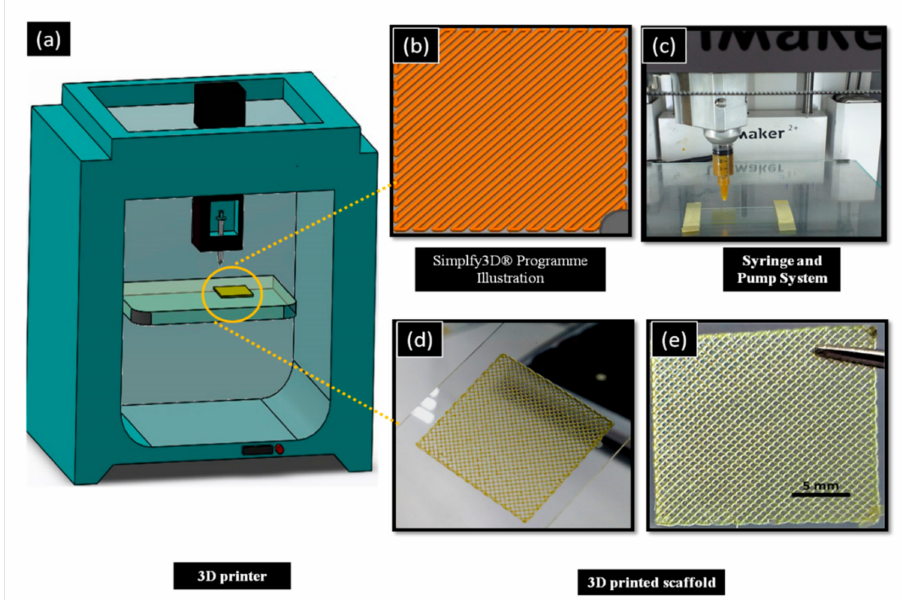
Figure 1. Schematic drawing of the experiment. ( a ) 3D printer. ( b ) Syringe pump system of machine. ( c ) Simplyf3D program illustration of sca ff olds. ( d ) 3D-printed sca ff old in glass slide before crosslinking. ( e ) After crosslinking of 3D-printed sca ff